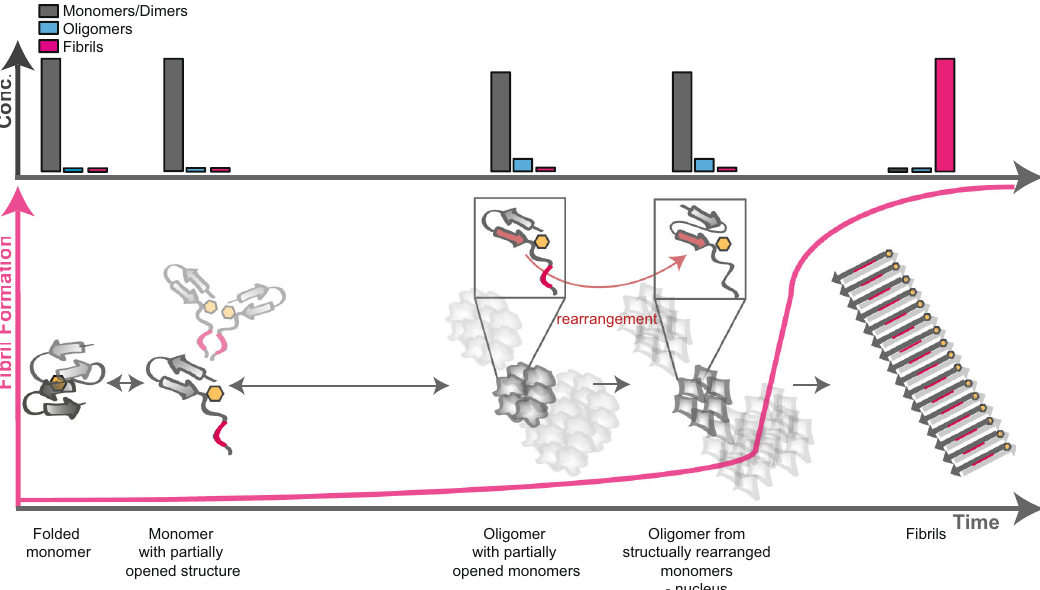
Fig. 6 Model of the events taking place in the lag phase of fi bril formation. Folded V L monomers undergo a partial structural opening whereupon they assemble to dimers, and oligomers (hexamers and multiples of hexamers). Prior to fi bril formation, the monomers in these oligomers structurally rearrange resulting in parallel β -sheets. This variant is the nucleus of fi brillization. The above bars show the concentration of each species at the respective timepoint of the fi bril formation process. The concentration of oligomers is low at all